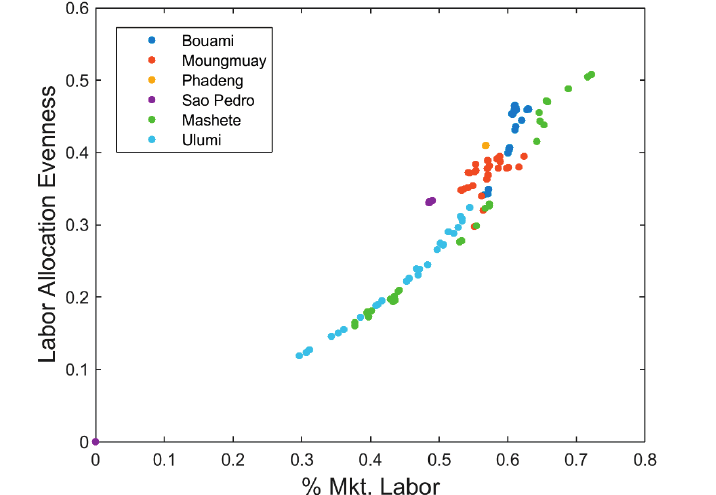
Figure 3. Livelihood diversity, measured as evenness of labor allocation across possible livelihood activities, increased as market-oriented labor increased. Data points for each site include mean values for baseline and experimental